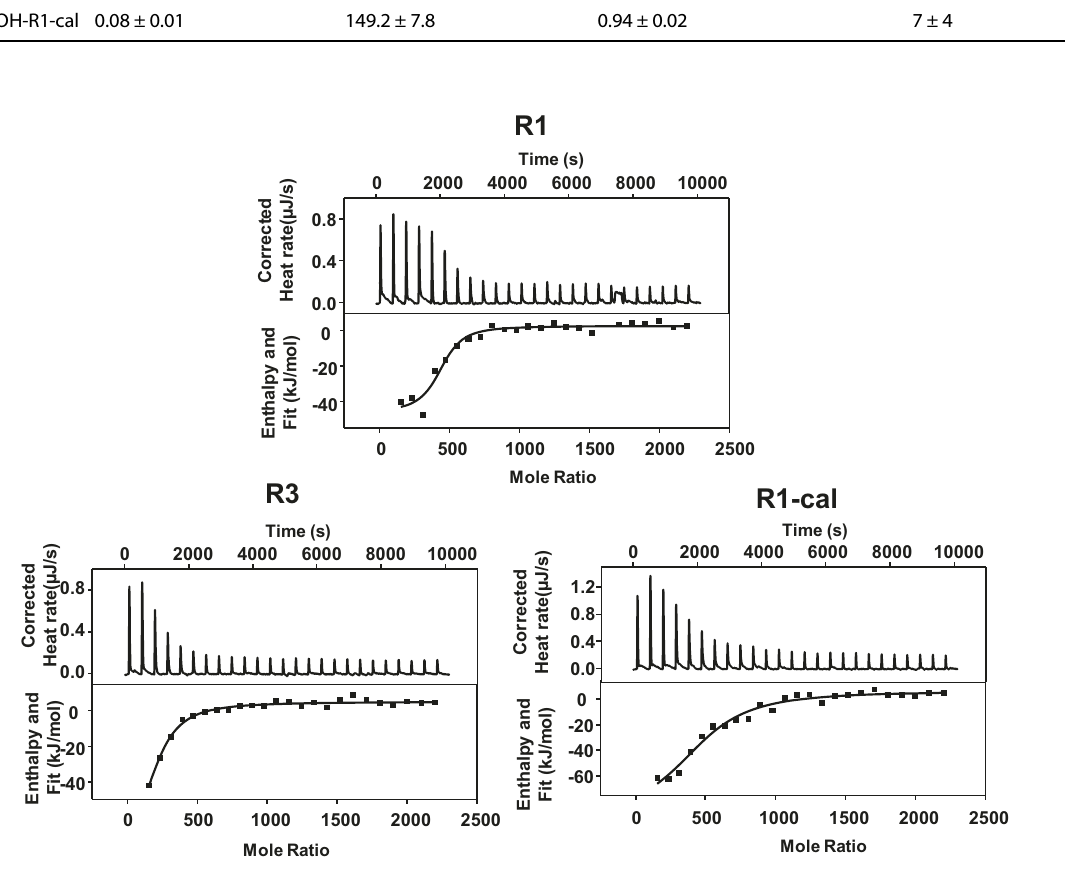
Fig. 4 ITC analysis of the titration of OVA to AlOOH nanorods. Heat fl ow versus time during the injection of OVA over AlOOH nanorods (top panel) and heat evolved per mole of added OVA against the molar ratio per injection (bottom panel) for A R1, B R3, and C R1-Cal. All titrations were performed at a pH of 7.4 and 25 °C. Calcinated nanorods R1 were prepared at 350 °C in a muf fl e furnace for one